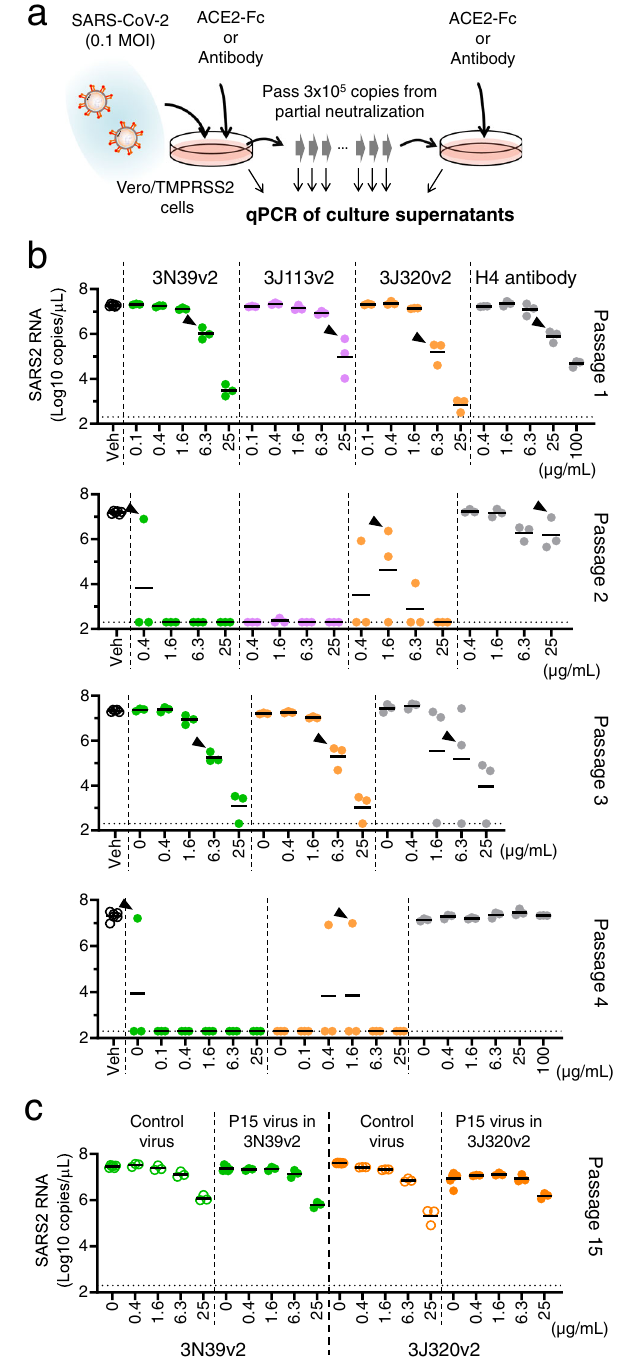
Fig. 3 No emergence of escape mutation under the treatment of modi fi ed ACE2-Fc. a Protocol of generating escape mutation in SARS-CoV-2. At fi rst, 0.1 MOI of SARS-CoV-2 was cultured in Vero6E/TMPRSS2 cells with indicated concentration of ACE2-Fc or H4 antibody, then a total of 3 ×10 5 copies of virus in partially neutralized well was passed in the presence of ACE2-Fc or H4 antibody dilution. Supernatants were collected from each well and analyzed virus RNA copy number by quantitative PCR. b The copy number of SARS-CoV-2 genome RNA in cultured medium was analyzed in each passage. The virus from indicated well (arrow head) was passed and escape mutant expansion was observed only in H4 antibody at passage 4. The test for 3J113v2 was discontinued due to no growth of virus at passage 2. c Viruses at passage 15 were neutralized similarly with the passaged control in